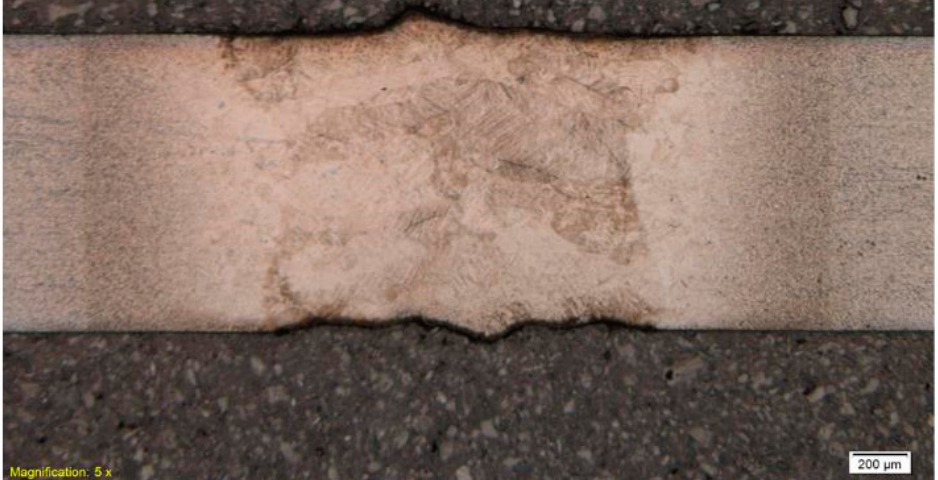
Figure 2. Macrograph cross-section of a sample.